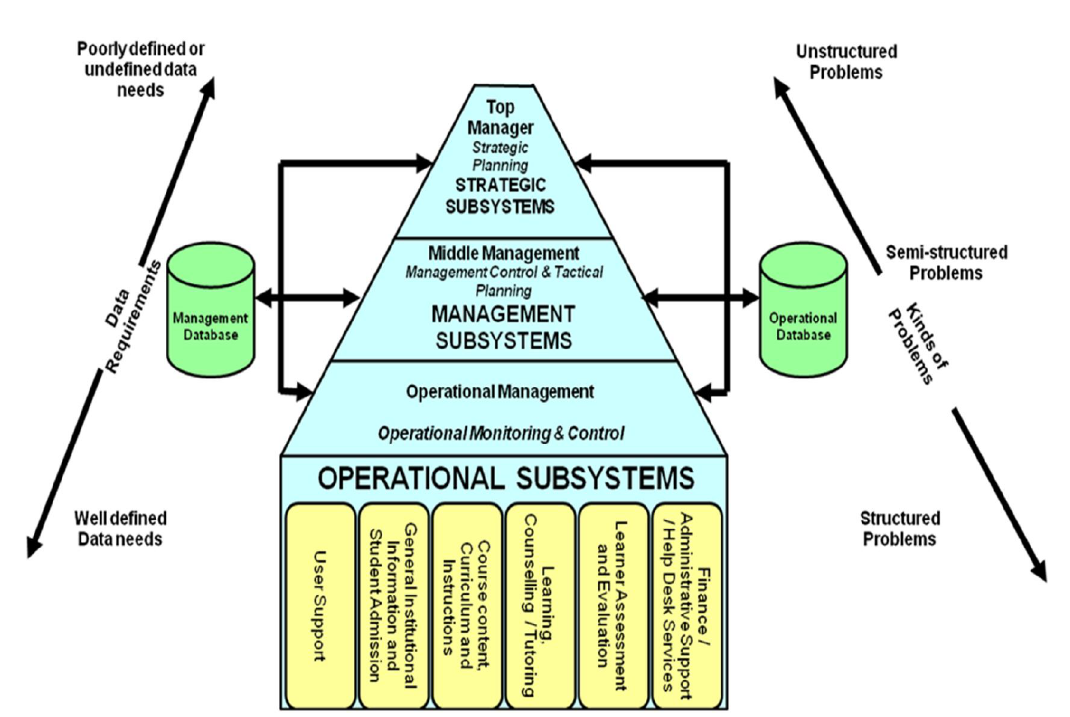
Fig. 2. Basic structure of the Integrated Information